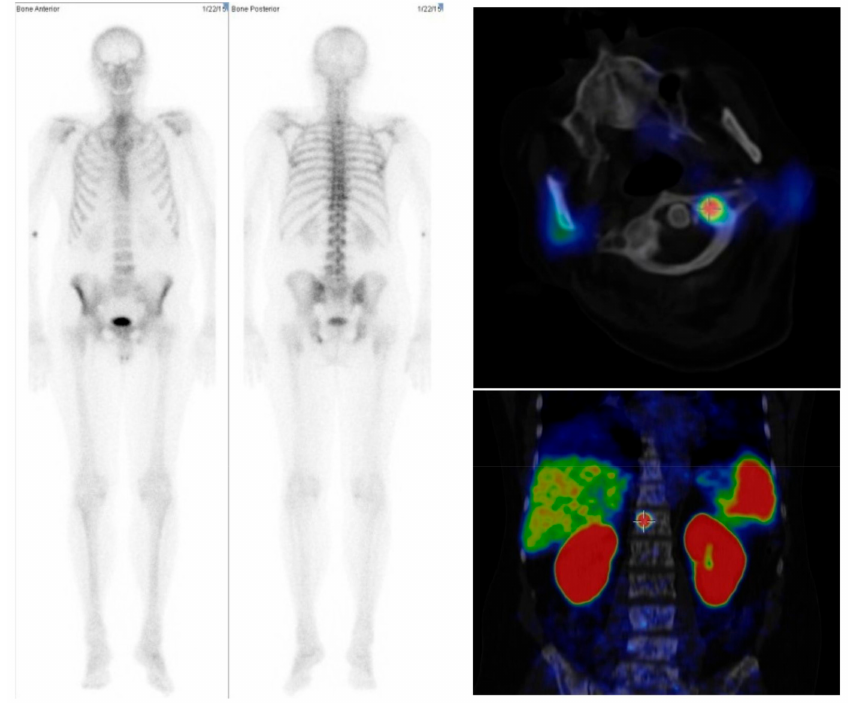
Figure 4. Example of a case in which the semiautomatic tool showed no lesions suspicious for metastases in the bone scan images ( Left and Middle ), while the visual analysis suspected bone lesions in the cervical, thoracic, and lumbar spine. PSMA-PET/CT agreed with these findings ( Right